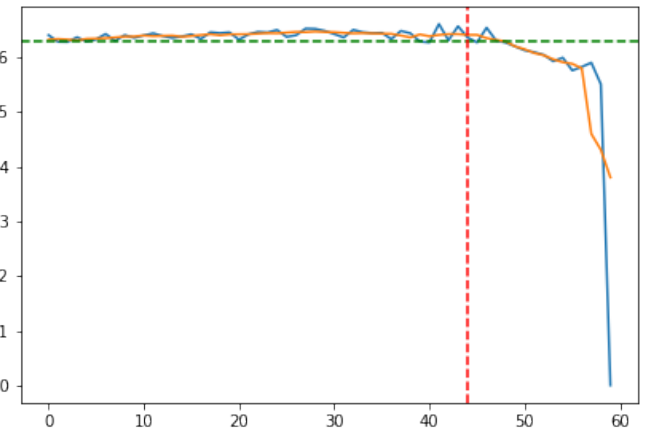
Figure 7. The accuracy of a model trained during the sequential backward selection (blue), smoothed accuracy (orange), accuracy averaged over the series excluding the segment of significant decrease (green), identified iteration